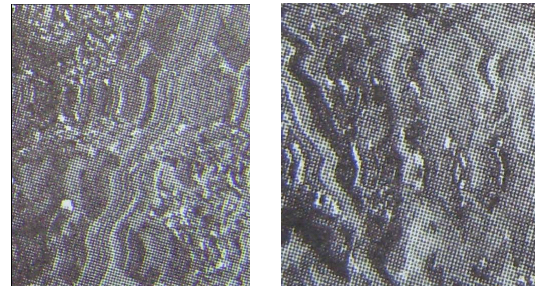
Figure 1. schematic of the image distortion caused by poor accuracy of IMU data 2.2.2.2. DEFORMATIONDEFORMATIONDEFORMATIONDEFORMATION IIIINSPECTIONNSPECTIONNSPECTIONNSPECTION MMMMETHODETHODETHODETHOD FORFORFORFOR DDDDIGITALIGITALIGITALIGITAL AAAAERIALERIALERIALERIAL IIIIMAGERYMAGERYMAGERYMAGERY BASEDBASEDBASEDBASED ONONONON SSSSTATISTICALTATISTICALTATISTICALTATISTICAL